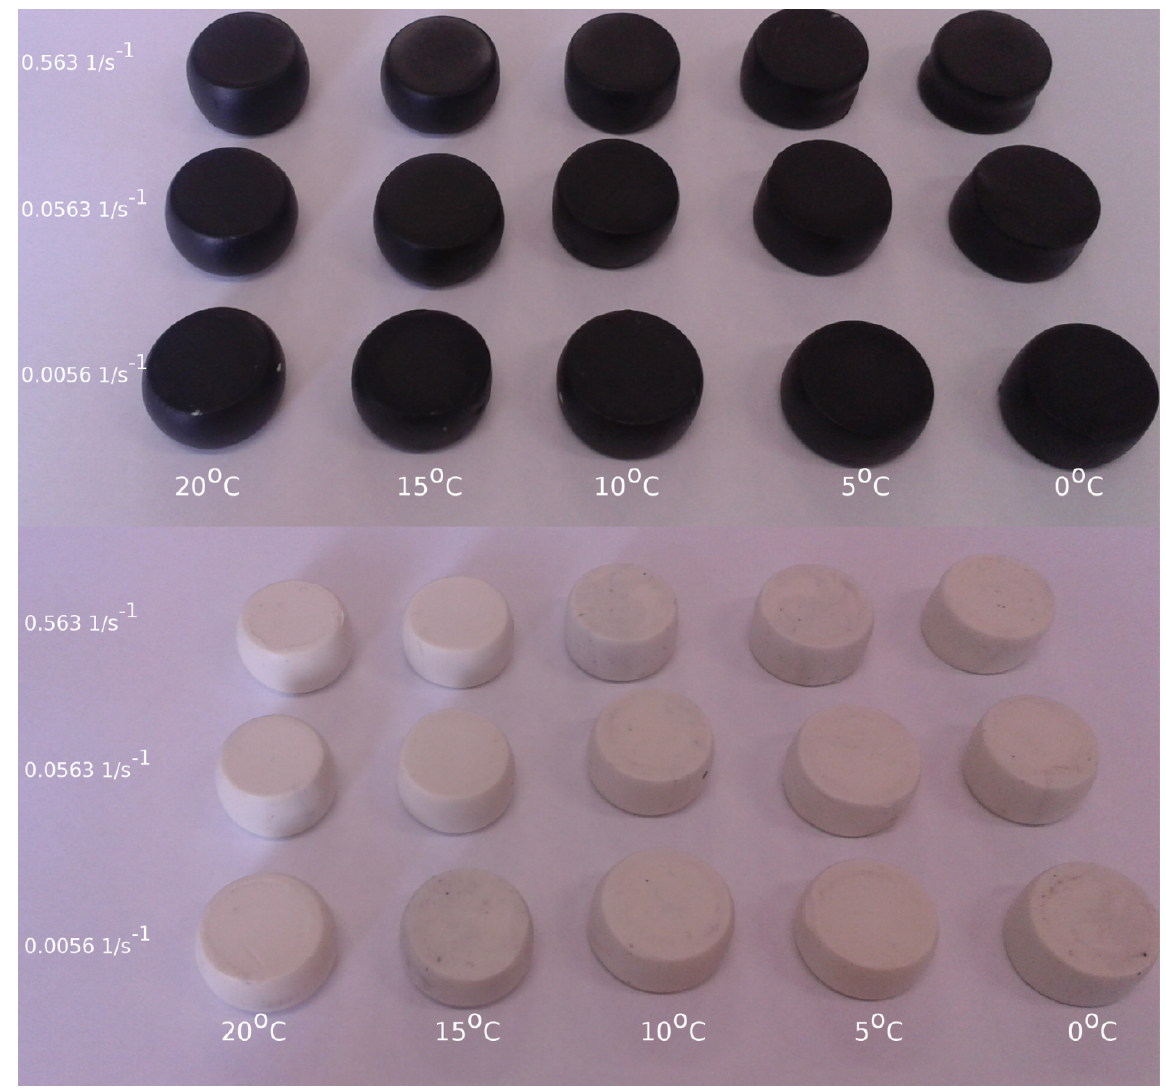
Figure 5: Upset forgings.